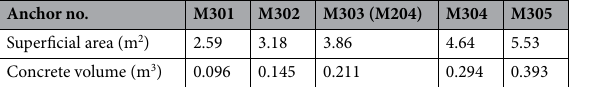
Table 7. Geometric parameters of group M3